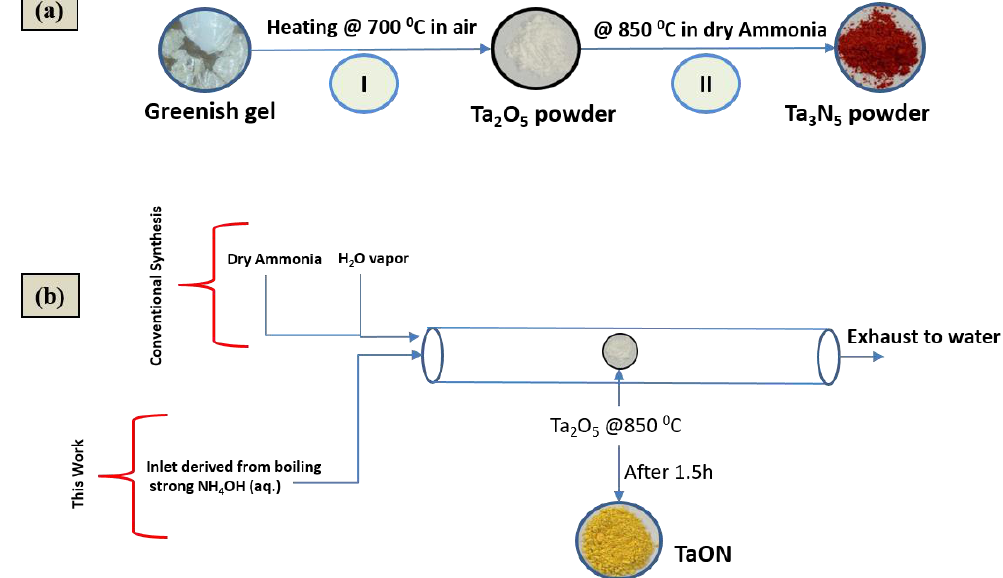
Figure 8. ( a ) The step-by-step process to synthesize (I) the oxide phase (Ta 2 O 5 ) from Ta-Precursor, and (II) the subsequent thermal treatment step for its complete nitridation (Ta 3 N 5 ) [63]. ( b ) The simplified method of nitridation for synthesizing TaON using NH 4 OH solution (NH 4 OH: H 2 O(v/v) = 150:100, temperature of the heating bath (ethylene glycol): 300